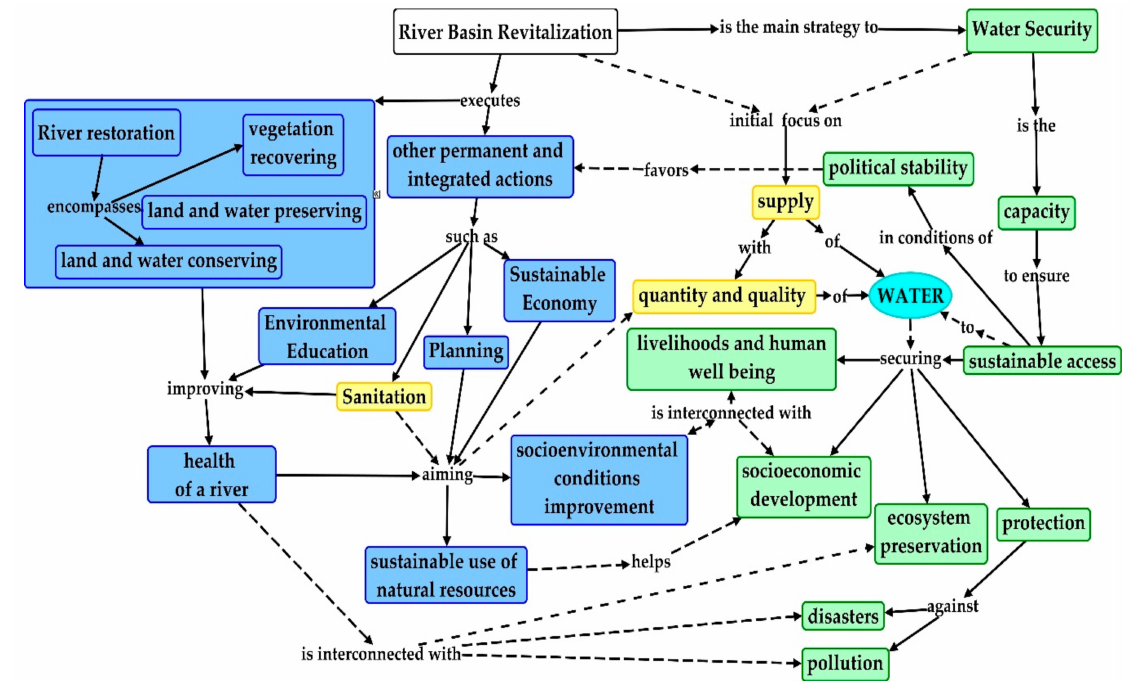
Figure 2. Concept map presenting the interdependence between river basin revitalization (blue boxes) and water security (green boxes). The relationships between them are represented by lines that link the boxes and by related words (connectors) that describe the nature of the relationship that binds them. The yellow boxes show the link to safe water components (supply, quality and quantity, sanitation), which corresponds to the ancient safe water source concept, focused on sanitation and